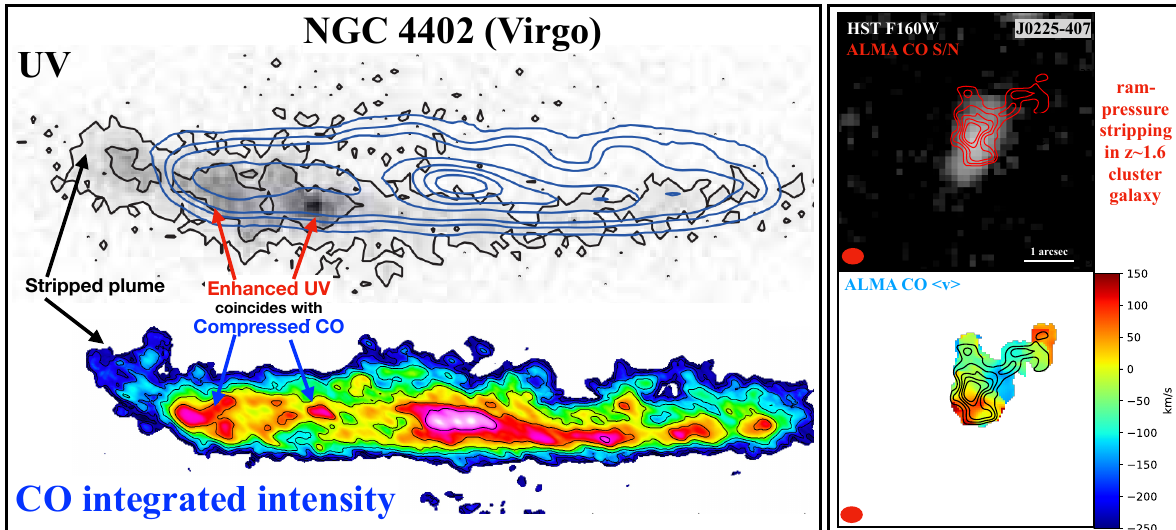
Figure 16. ( left ) Adapted from Lee et al. [733] and Cramer et al. [719] in top and bottom panels, respectively. The locations of UV peaks (gray-scale, top) correlate with sites of molecular gas compression (CO, bottom) in a ram-pressure stripped galaxy in Virgo. ( right ) Adapted from Noble et al. [677]. ALMA CO observations of a z ∼ 1.6 cluster galaxy display similar indications of ram- pressure stripped molecular gas tails (2 − 6 σ red contours on grayscale HST F160W in upper right panel), including a strong kinematic signature—accelerated gas toward the tip of the tail (color image in bottom right panel). Figures reproduced by permission of the